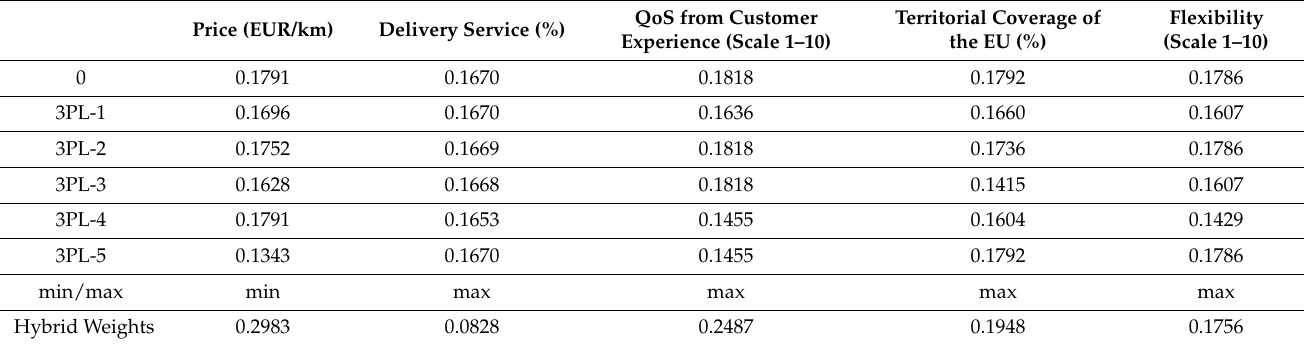
Table 12. Normalization of the input data (Source: